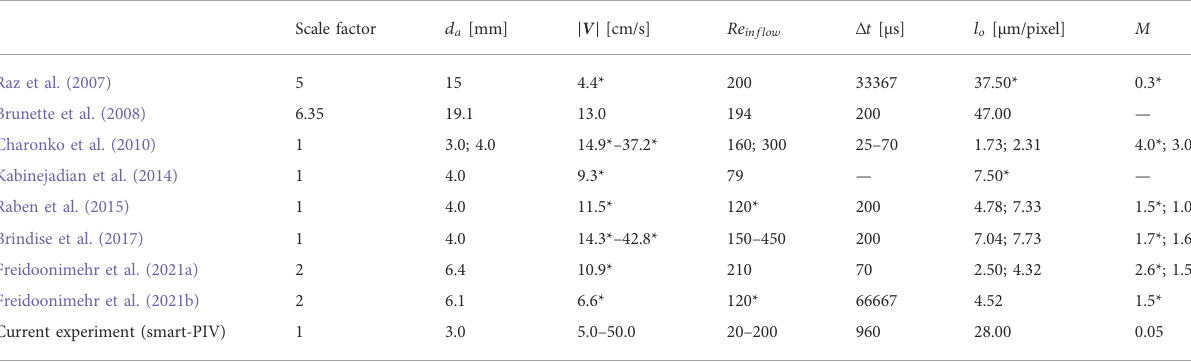
TABLE 1 Flow parameters and PIV spatial and temporal resolutions adopted in in vitro PIV experiments on coronary fl ows. d a , inlet artery model diameter; | V | ,meanin fl owvelocity Re inflow ,in fl owReynoldsnumber; Δ t ,timeintervalbetweentwoconsecutiveframes; l o ,imageresolution; M , magni fi cation